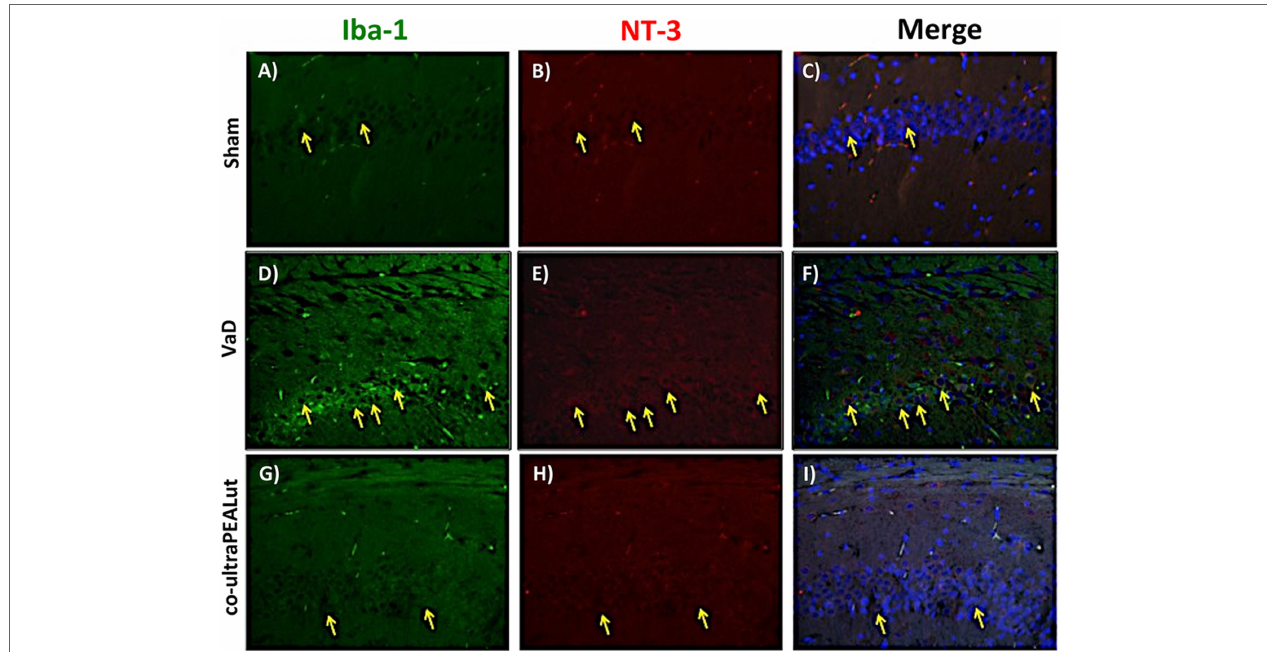
FigUre 12 | co-localization of iba-1/nT-3 after carotid arteries ligation . Results are shown for Sham group (a–c) , mice after carotid arteries ligation (D–F) , mice treated with co-ultraPEALut (g–i) . Brain sections were double stained with antibodies against Iba-1 [ (a,D,g) , green] and NT-3 [ (B,e,h) , red]. Hippocampal sections revealed increased microgliosis (D) in VaD group. Iba-1 immunoreactivity was reduced in co-ultraPEALut-treated mice (g) . Yellow spots indicate co-localizations and revealed a high co-localization between Iba-1/NT-3 double staining (c,F,i) . The pictures are demonstrative of at least three experiments executed on distinctive experimental days. Images are representative of all the animals in every group. All images were digitalized at a resolution of 8 bits into an array of 2,048 × 2,048